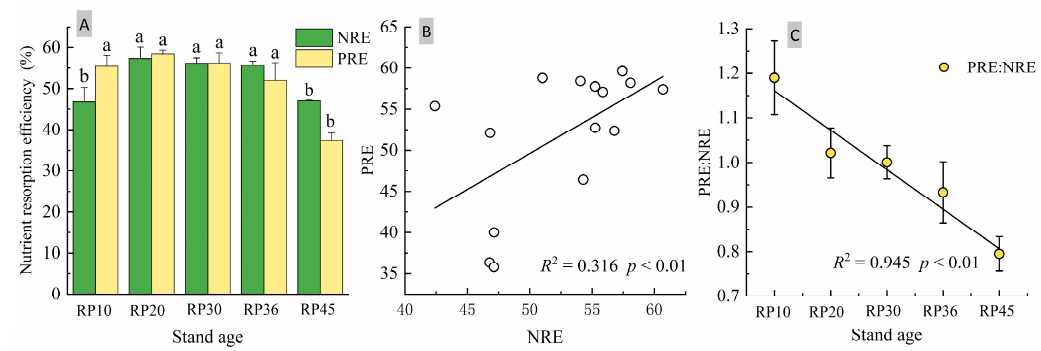
Figure 2. ( A ) Changes of N and P resorption efficiency (NRE and PRE), ( B ) PRE:NRE along the chronosequence of black locust forests, and ( C ) the relationship between NRE and PRE. Data are shown as the mean ± standard deviation. Different lowercase letters represent significant differences among stand ages at p < 0.05, and the same letters indication no significant difference.